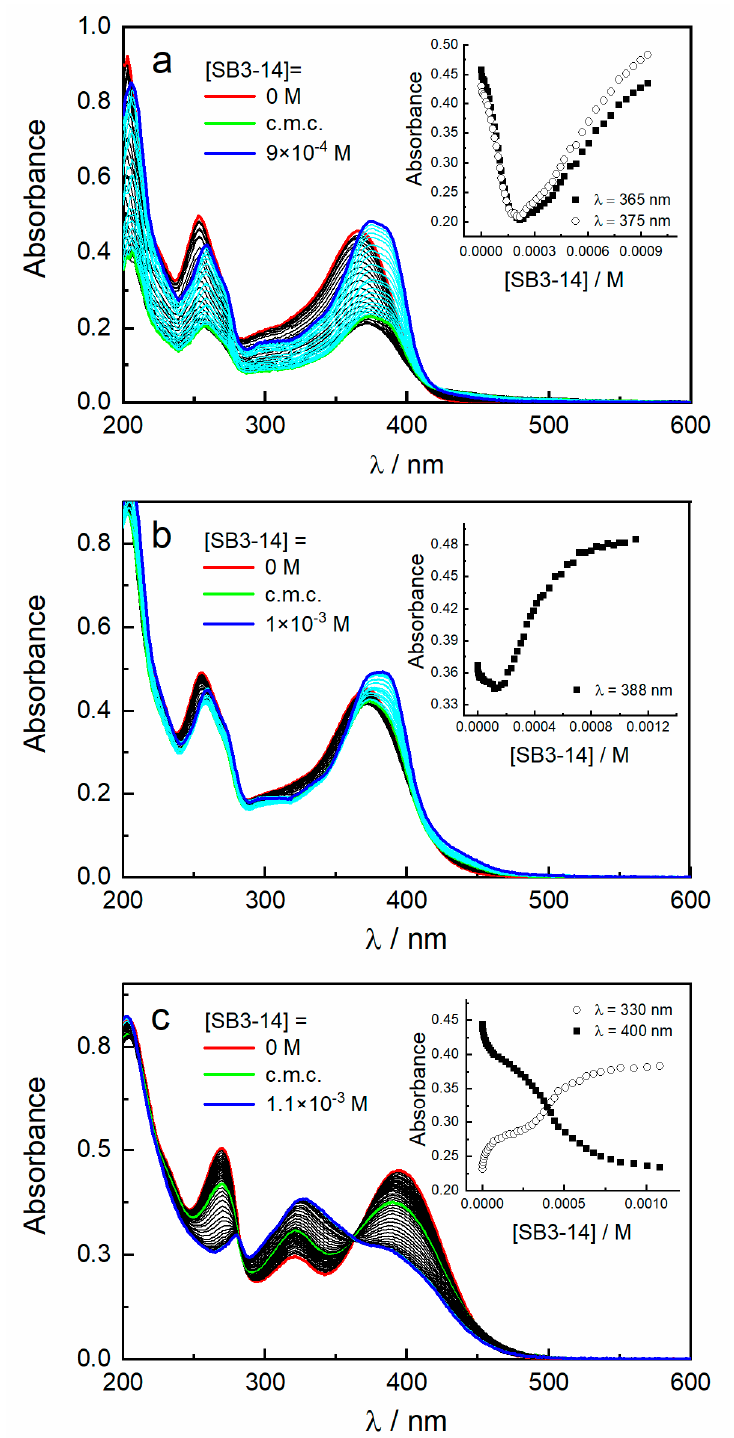
Figure 2. Absorption spectra of quercetin in aqueous pH 5.5 ( a ) and buffered solutions at pH 7.0 ( b ) and 9.0 ( c ) alone and in the presence of increasing amount of SB3-14 up to 1 × 10 − 3 M. Inset: variation of the absorbance of quercetin upon SB3-14 concentration at specific wavelengths.